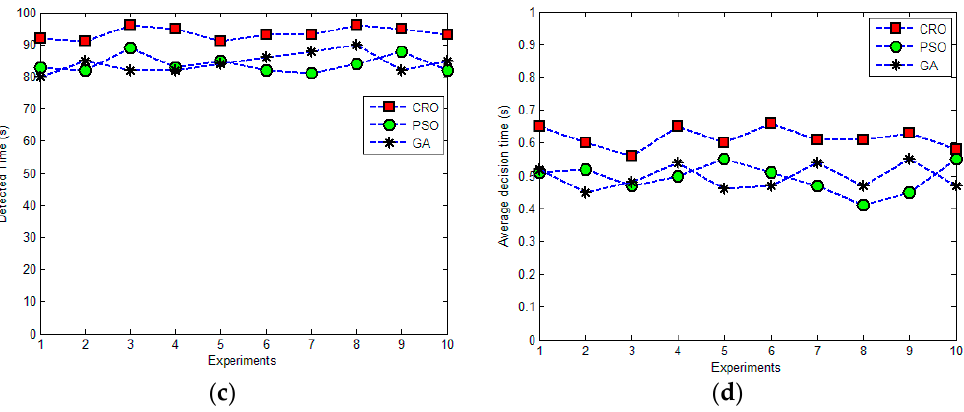
Figure 9. The performances of using different evolutionary optimizers for determination of the tracking path for scenario 2. ( a ) and ( b ) illustrate the convergence of different methods in selected decision time, respectively; ( c ) shows the visibility time of the ground time for the proposed method, PSO and GA based algorithms, respectively; ( d ) is the average execution time of the aforementioned methods.